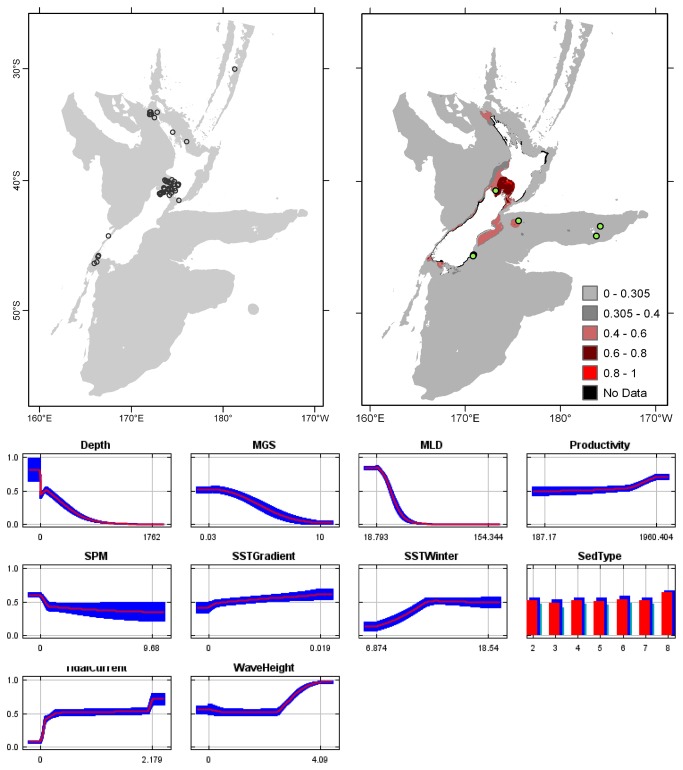

Cellaria

immersa
 known distribution (left), predicted suitable habitat (right), and fitted responses curves (marginal).For the predicted distribution, logistic probabilities less than the 10th percentile presence value indicated cells were unsuitable habitat. Probabilities of 0.4–0.6 indicated habitat suitability typical of the presence records, values of 0.6–0.8 and 0.8–1 indicated favourable and highly suitable habitat, respectively. Black cells had missing data in one or more environmental layer. Independent records are layed over the predictions. Marginal response curves show how the prediction changes for different values of each variable when all other variables were at their average sample value. Individual response curves are shown in Figure S3. For the categorical variable Sediment type: 1 = deep ocean clays; 2 = calcareous gravel; 3 = volcanic; 4 = calcareous mud; 5 = gravel; 6 = mud; 7 = sand; 8 = calcareous sand.